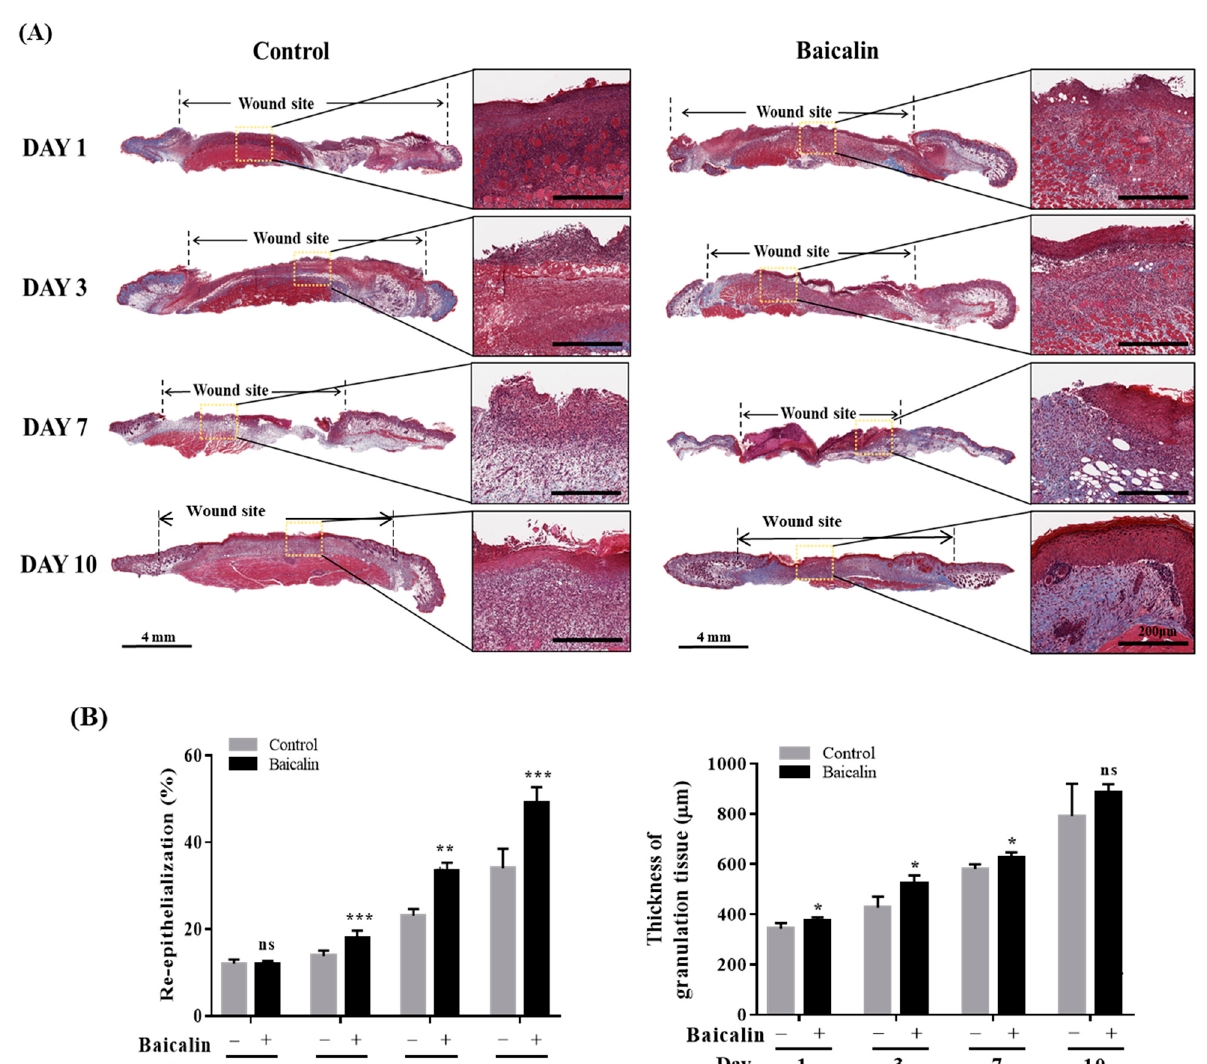
Figure 4. Treatment with baicalin accelerates the restoration of skin structure in a chronic murine model of skin ulcers. ( A ) Representative Masson’s trichrome (MT) images acquired at wound sites on days 1, 3, 7, and 10. Scale bar: 4 mm, 200 μ m. ( B ) Quantitative analysis of the re-epithelialization and granulation tissue was performed using ImageJ. All images are representative of three independent experiments ( n = 18). * p < 0.05, ** p < 0.01, *** p < 0.001, ns: not